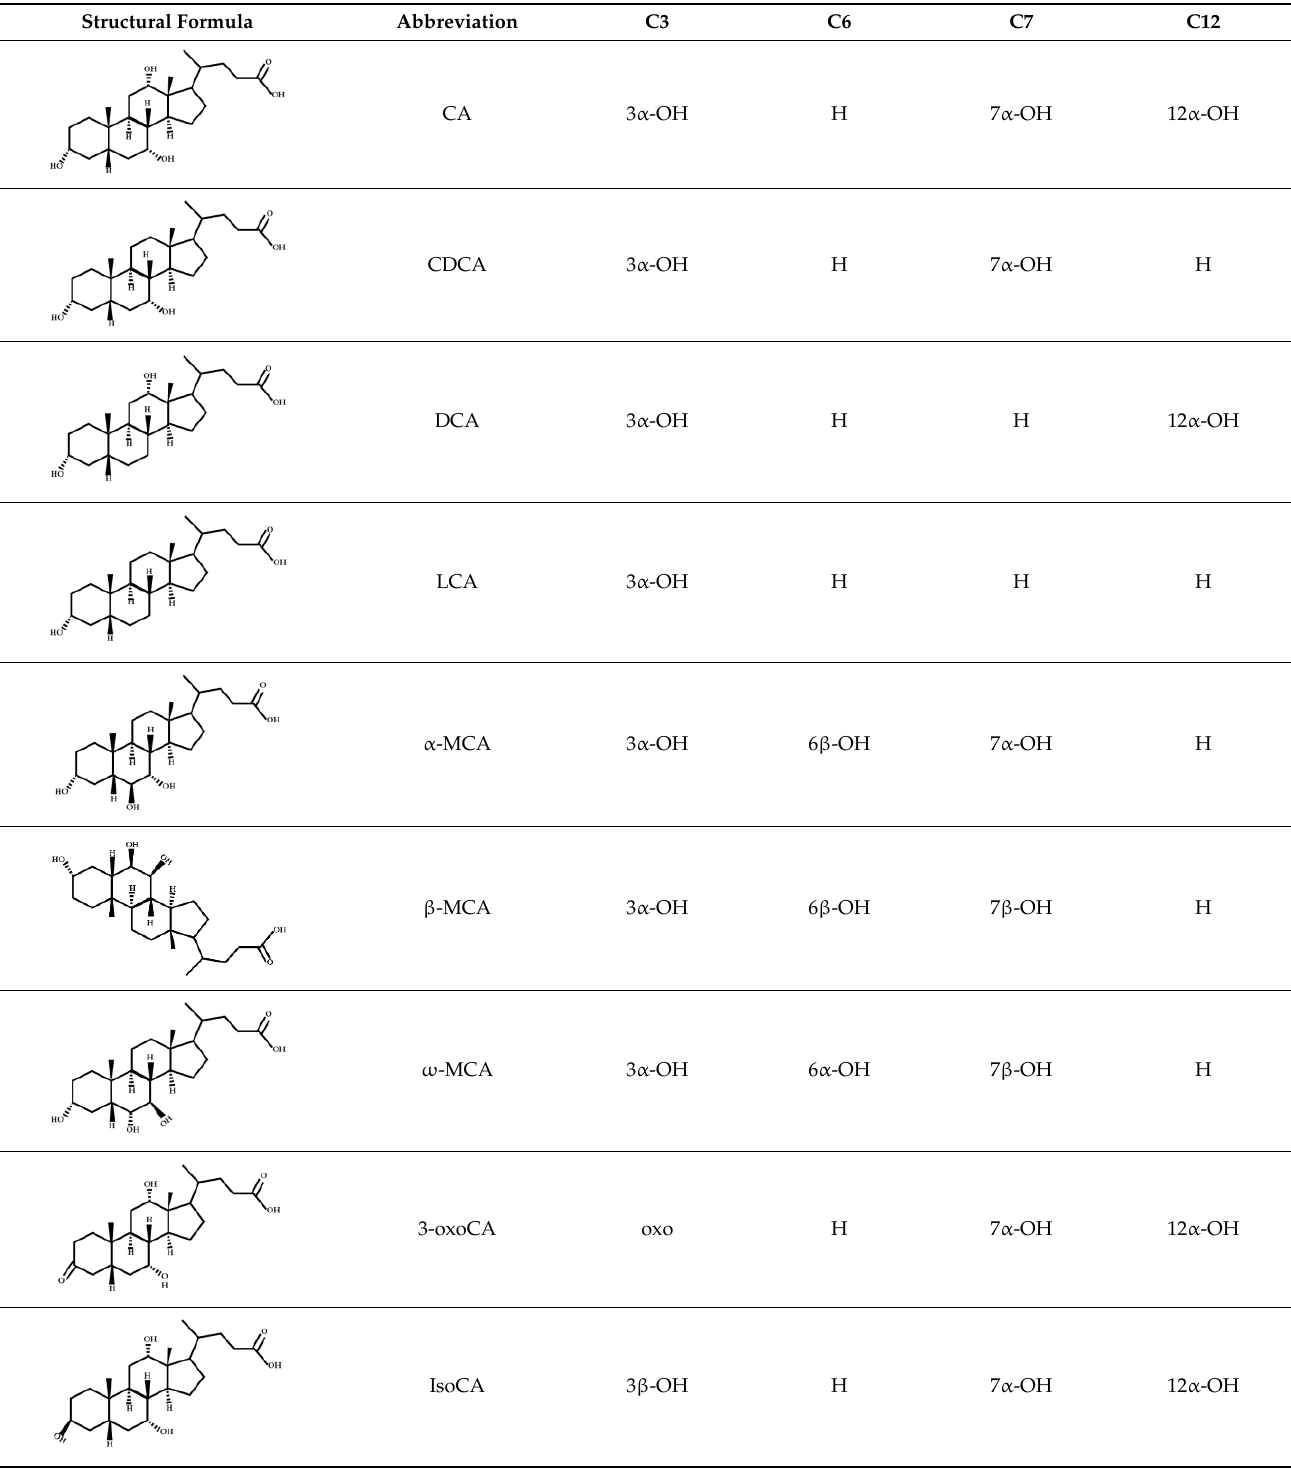
Table 2. The structures of bile acids: The structural formula of bile acids and bile acid intermediates along with the hydroxyl positions are presented below, and the hydrophobicity of bile acid can be assessed according to their stereoscopic configurations.